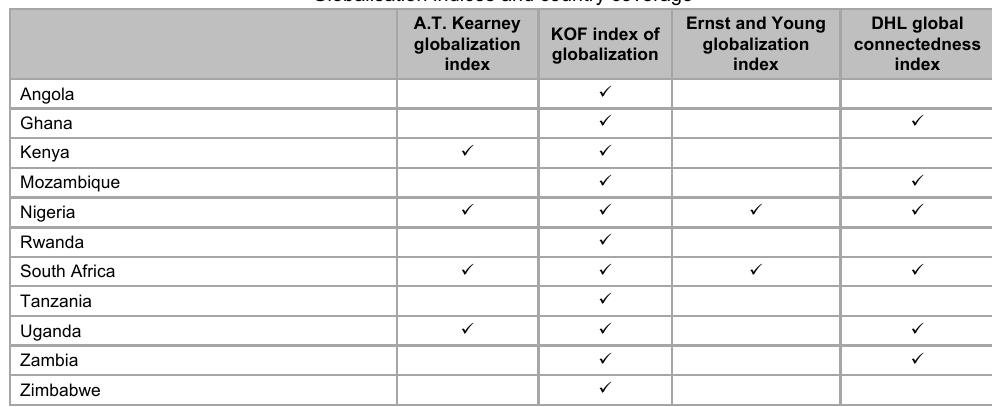
Globalisation indices and country